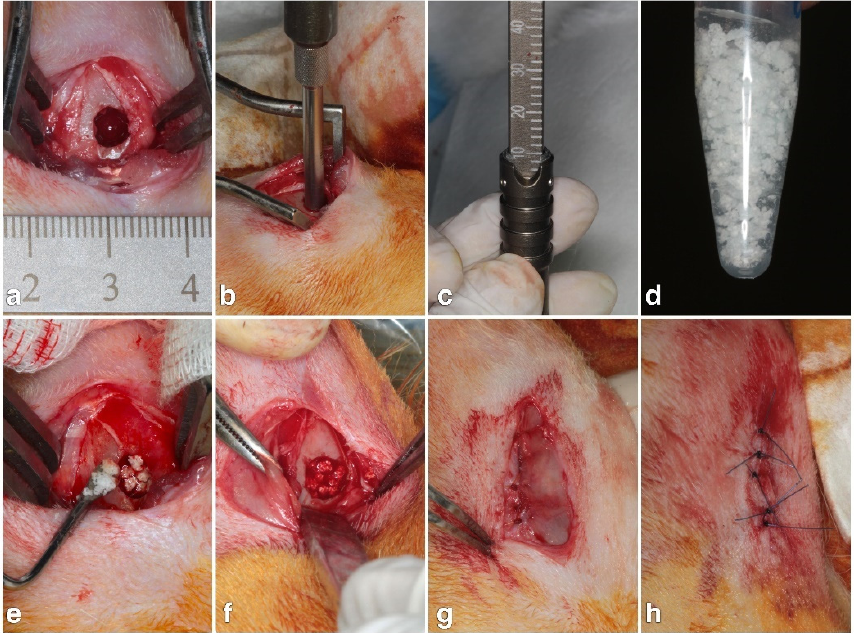
Figure 1. ( a ) Surgical incision and exposure of lateral femoral condyle. ( b , c ) Bony defects 5 mm in diameter and 10 mm in length were created in both femurs using a surgical drill. ( d ) Bone substitute mixed with hyaluronic acid hybrid. ( e , f ) Grafting material filled into the defect site. ( g ) Inner suture to close periosteum. ( h ) Outer flap suture for primary wound closure.